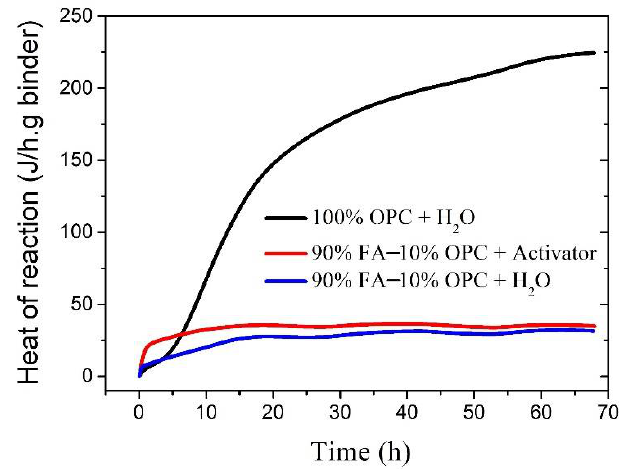
Figure 6. Total heat of reaction of the pastes. Table 3. Total heat of reaction of the pastes up to 70 h of testing.